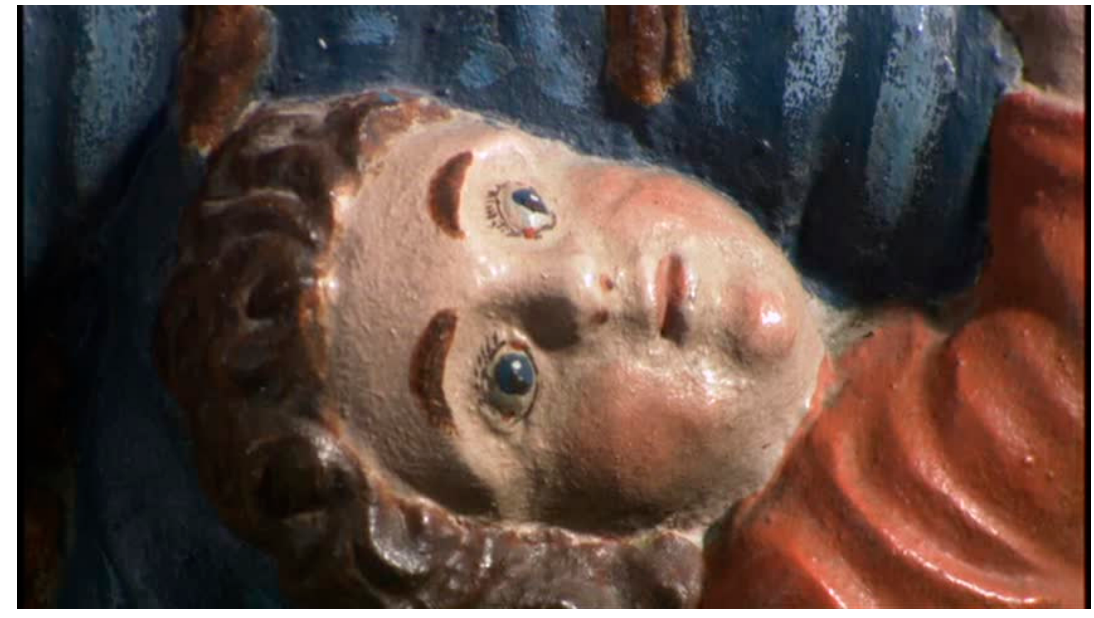
Figure 21. Light, Art, Prayer.